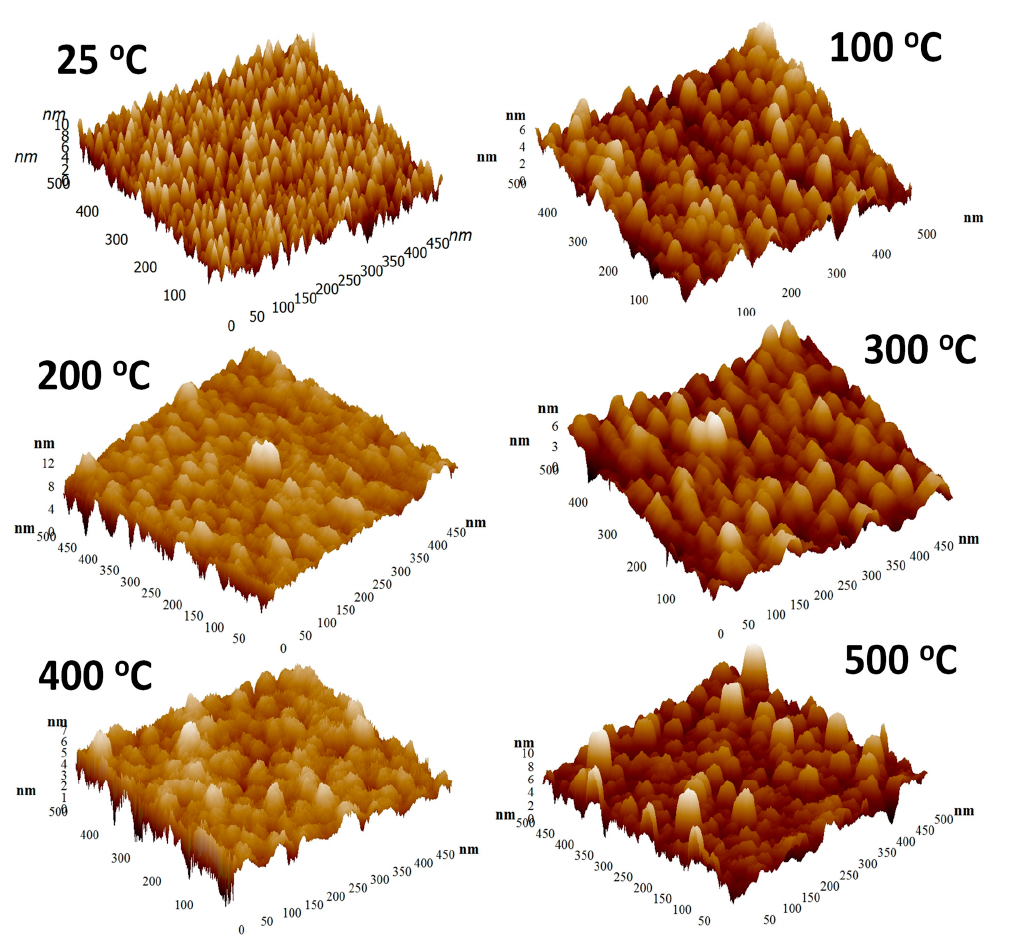
Figure 3. The corresponding three-dimensional surface AFM images of Mo films deposited at various temperatures. It is evident from these images that the grain size and surface roughness evolution in Mo films is dependent on the deposition temperature.